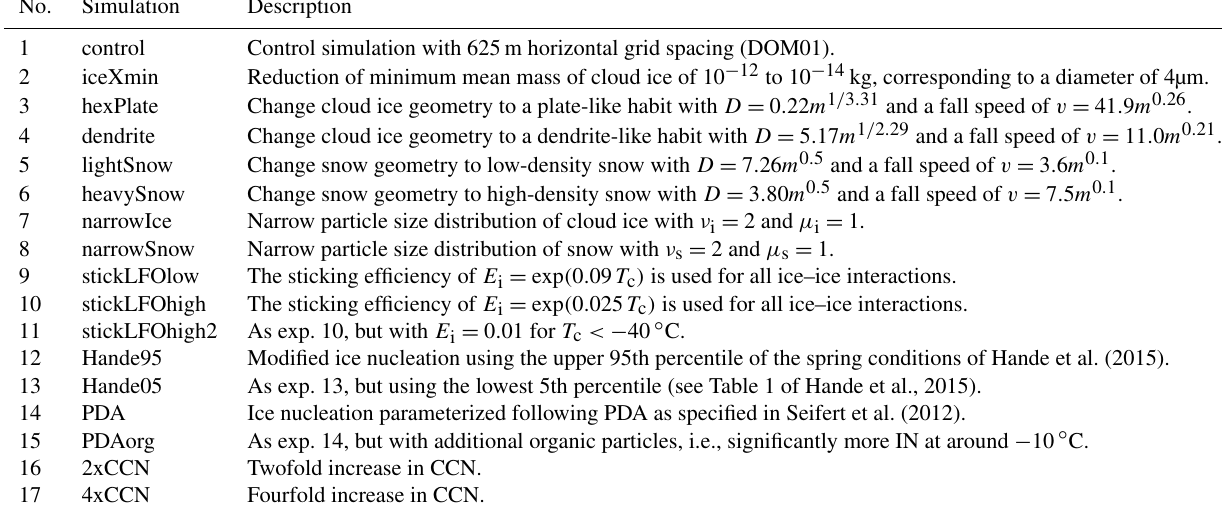
Table A1. Overview of the microphysical sensitivity experiments. In the SB scheme ice particles are characterized by power laws that relate the maximum dimension D and the terminal fall velocity v to particle mass m . The control simulation uses D = 0 . 835 m 0 . 39 and v = 27 . 7 m 0 . 216 for cloud ice, where D is in meters, v in meters per second (ms − 1 ), and m in kilograms. For snow the control assumes D = 5 . 13 m 0 . 5 and v = 8 . 3 m 0 . 125 . The particle size distribution is a generalized gamma distribution of the form f (m) = Am ν exp ( − Bm µ ) , and the control run uses the shape parameters ν i = 0 and µ i = 1 / 3 for cloud ice and ν s = 0 and µ s = 0 . 5 for snow. T c is the cloud effective temperature.